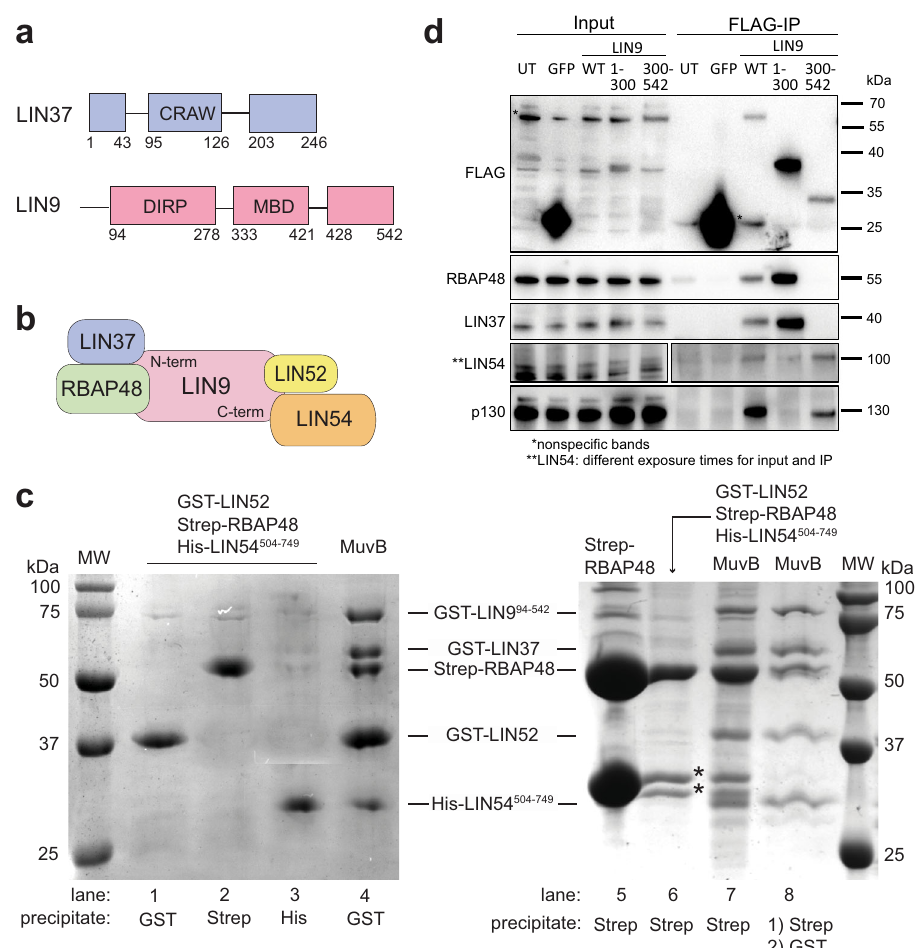
Fig. 1 LIN9 and LIN37 scaffold the MuvB complex. a Domain architecture of human LIN9 and LIN37, with regions of predicted and validated structure shown as blocks. The conserved LIN37 CRAW domain and LIN9 DIRP domain structures are determined here. MBD is the MYB-binding domain. b Schematic model for subunit interactions within MuvB. c The indicated tagged subunits or MuvB complex (GST-LIN52, Strep-RBAP48, His-LIN54 504 – 749 , GST-LIN37, and GST-LIN9 94 – 542 ) were expressed in Sf9 cells and extracts were precipitated with resin capturing the indicated tag. Proteins were visualized with coomassie staining. *Indicates impurities or degradation observed in some RBAP48 expressions. These bands are not pulled out from the tandem puri fi cation. The experiment was repeated three times with similar results. d HCT116 cells were transfected with plasmids encoding the indicated FLAG-tagged mouse protein. FLAG-tagged proteins were precipitated from extracts using anti-FLAG antibody and visualized with anti-FLAG immunoblotting and immunoblotting with antibodies that recognize RBAP48, LIN37, LIN54, and p130. A biological replicate of the experiment was performed, and results